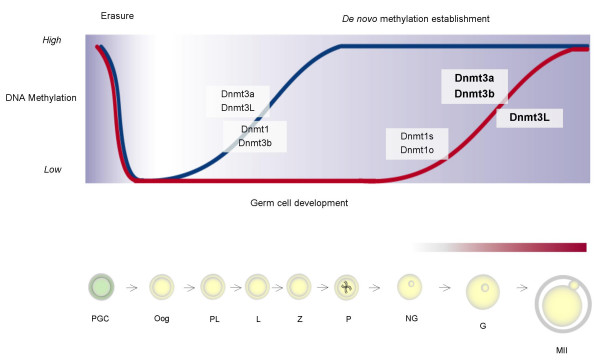
Onset of DNA methyltransferase expression during mammalian germ cell development. The results presented in this paper as well as observations made for the male germ line [25, 26] are depicted here in relationship to the timing of de novo methylation establishment on imprinted genes and repeats during germ cell development. The figure is adapted from [47]. The top panel illustrates the methylation dynamics of maternally and paternally methylated imprinted genes, depicted by the red and blue lines respectively. During gametogenesis the pattern of non-imprinted gene methylation closely resembles that of imprinted genes. The time at which DNA methyltransferases are expressed during germ cell development are indicated with the transcripts examined in this study highlighted in bold. Although expressed at similar stages of oogenesis, the de novo DNA methyltransferases, Dnmt3a and Dnmt3b, are grouped separately from Dnmt3L which does not have DNA methyltransferase activity. The onset of Dnmt1o expression has been previously shown in early growing oocytes [43]. Our findings show that the expression of Dnmt3a, Dnmt3b and Dnmt3L coincide with the establishment of DNA methylation on imprinted genes and repeat sequences in the female germ line. The progression of methylation imprint acquisition during oogenesis is illustrated in the bottom panel and depicted by the red shading above the female germ cells. PGC = primordial germ cell, Oog = oogonia, PL = preleptotene, L = leptotene, Z = zygotene, P = pachytene, NG = non-growing oocyte G = growing oocyte, MII = metaphase II oocyte.